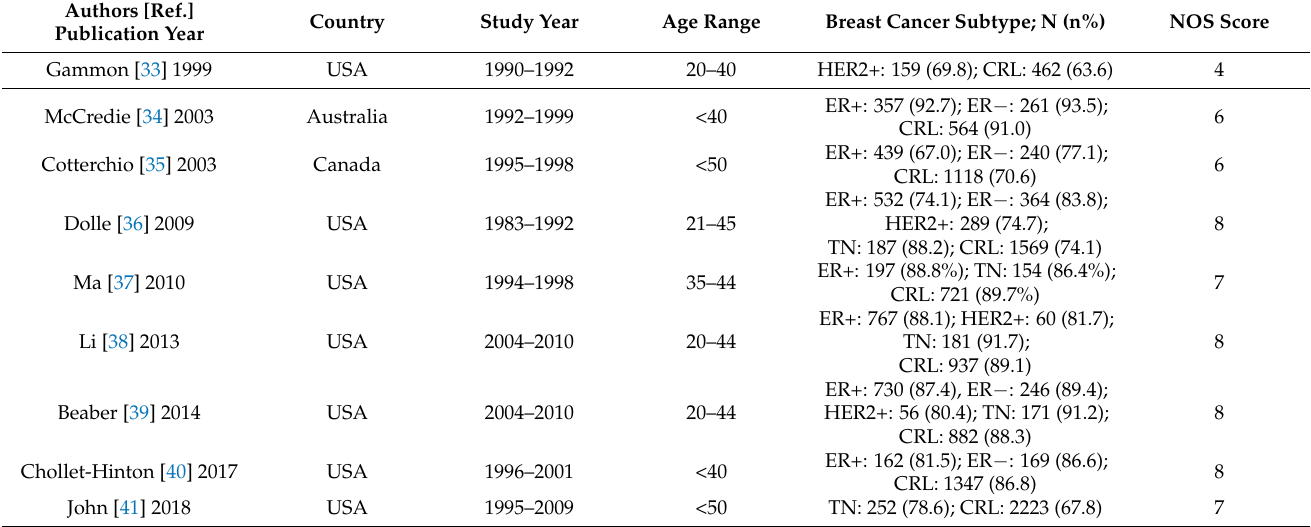
Table 1. Characteristics of included studies.